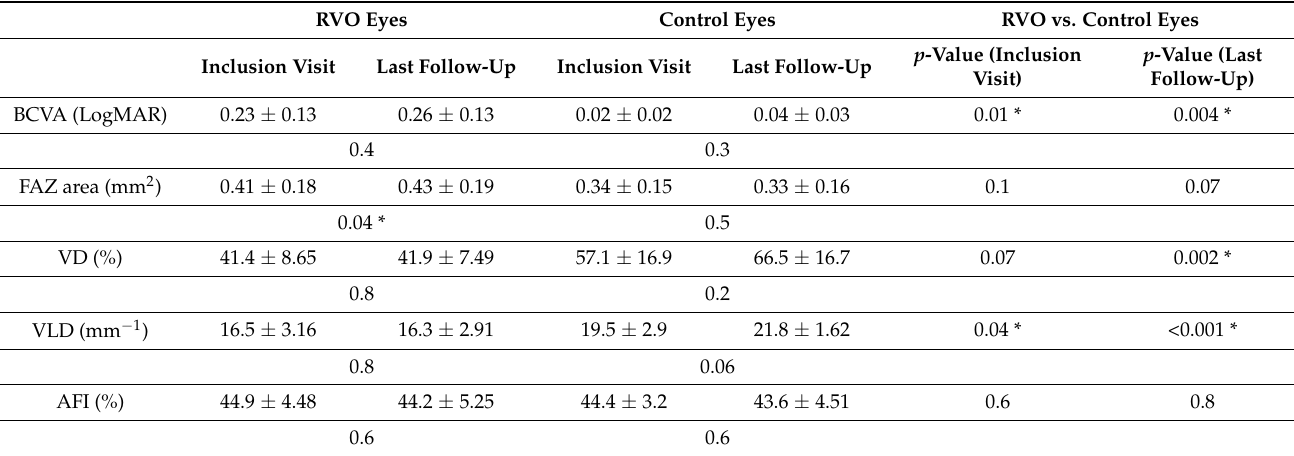
Table 2. Changes in optical coherence tomography angiography parameters and best-corrected visual acuity (BCVA) in retinal vein occlusion (RVO) and control eyes.